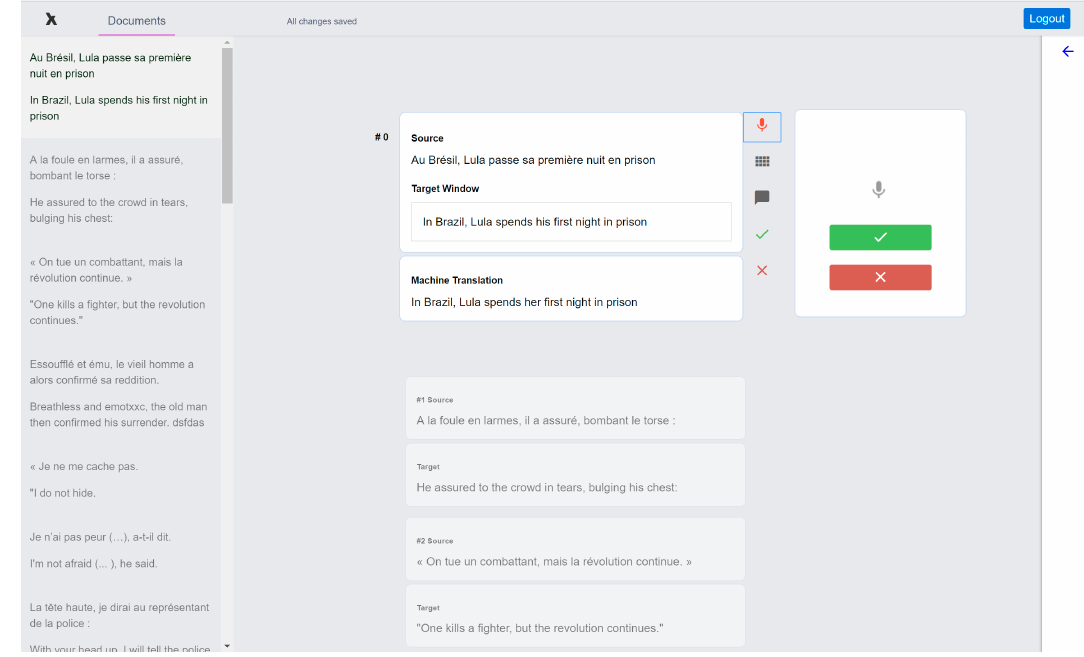
Figure 13. The Edit view in the second iteration of the tool.